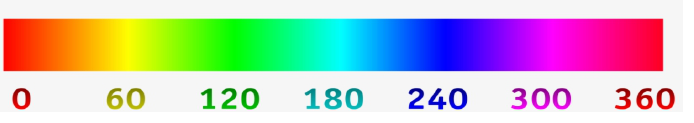
Figure 6. Representation scale of hue